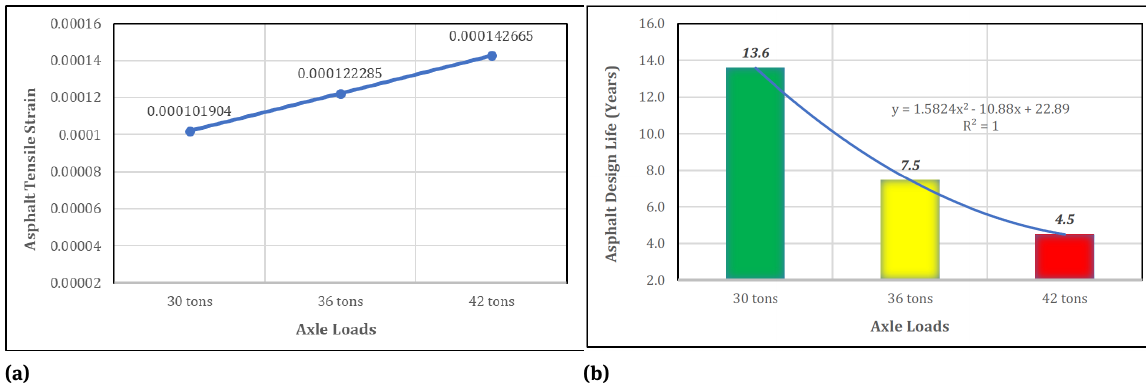
Figure 14: Axle loads effect on asphalt tensile strain (a) and on asphalt service life (b) in asphaltic overlayment rail track.